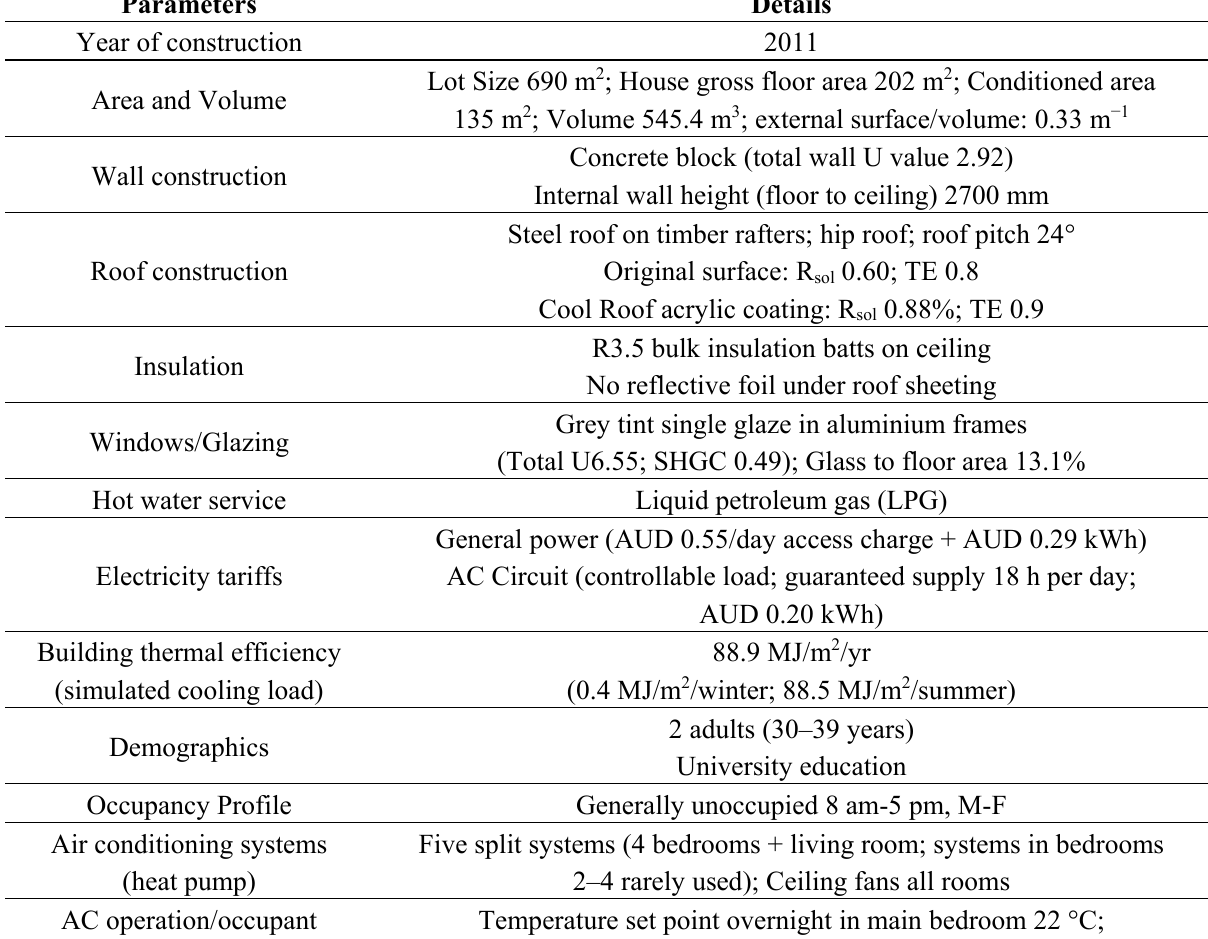
Table 3. Field study house